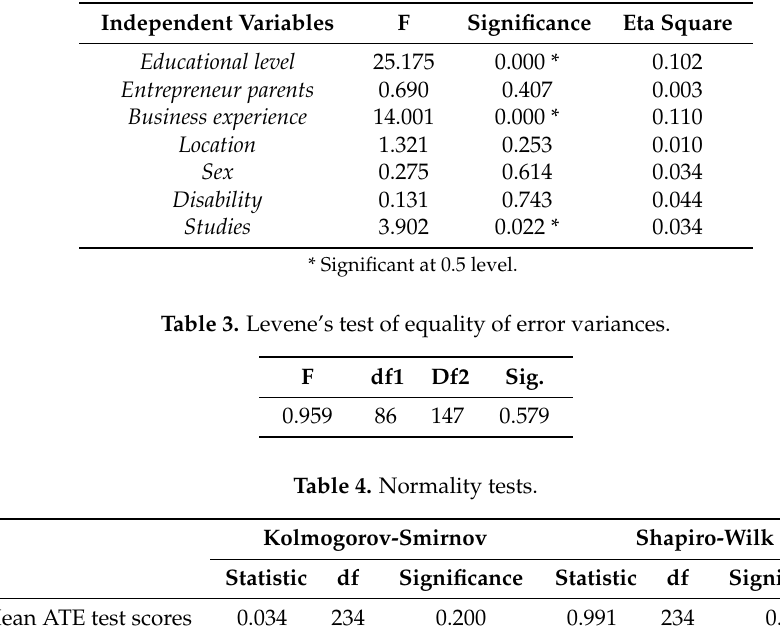
Table 2. Analysis of variance results.